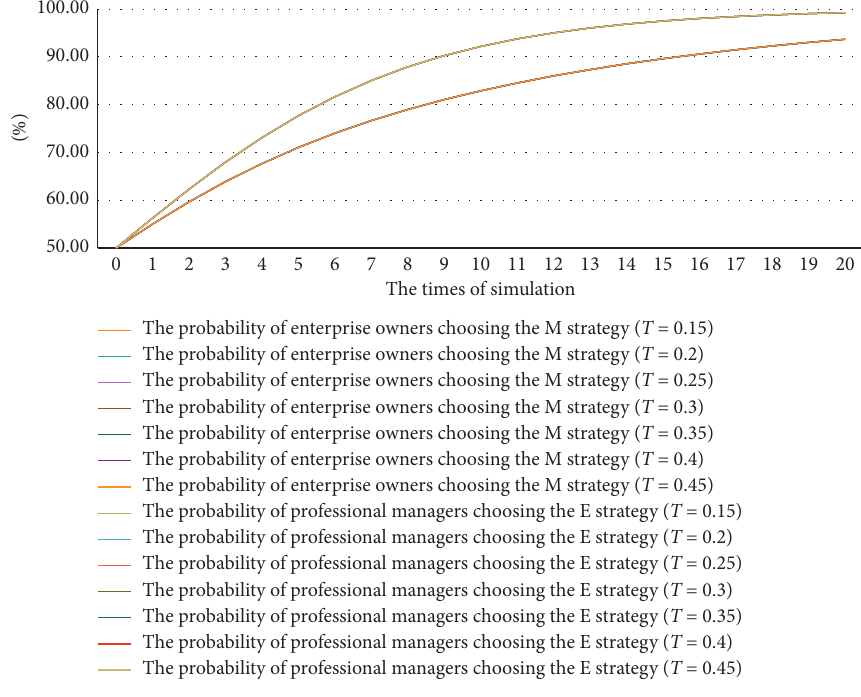
Figure 15: The impact of T on the evolutionary results.